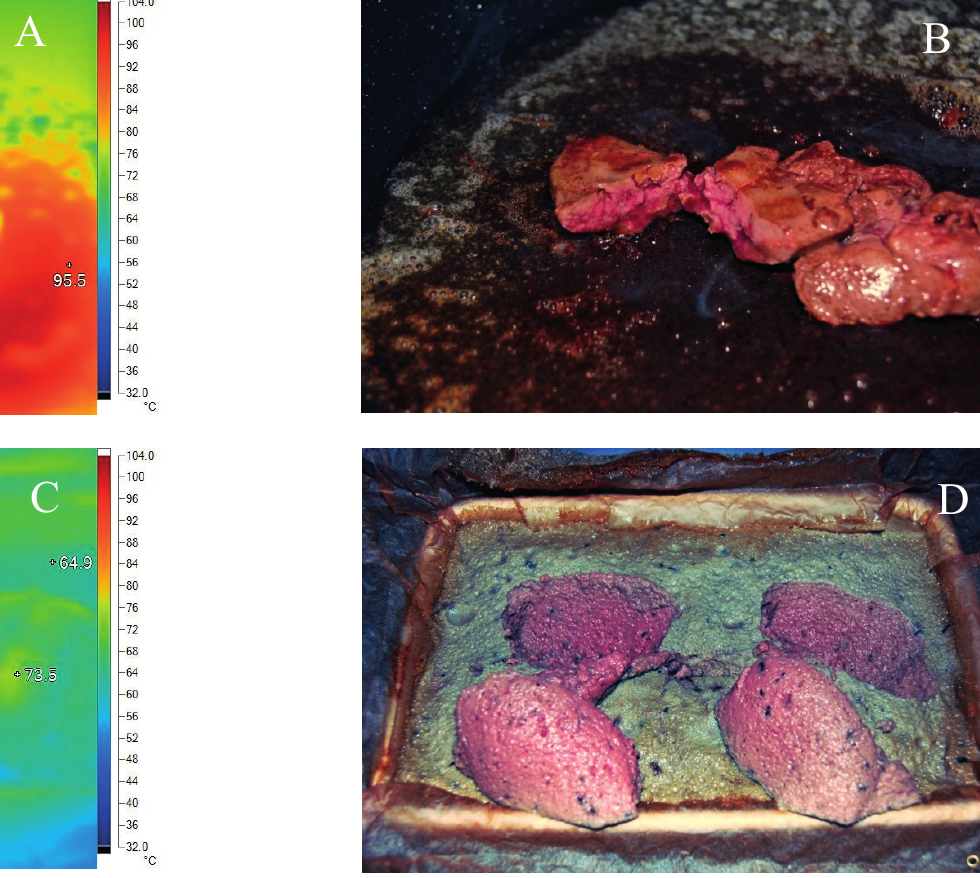
Figure 1. Thermographs showing surface and internal temperatures ( A and C ) and corresponding visible images showing color and appearance ( B and D ) after cooking by pan frying in butter on a surface at 100 °C for 100 sec on each side of the liver ( A ) or in a Bain Marie of boiling water placed in an oven set to 130 °C for 45 min ( B ). Both sets of cooked livers were subject to 10–15 sec of cooling before the thermographs could be taken. The Bain Marie cooked pâté set only after cooling and was subject to rheological movements between image